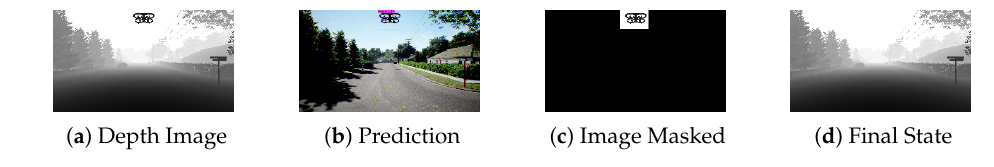
Figure 3. Drone Detection and Image Processing.